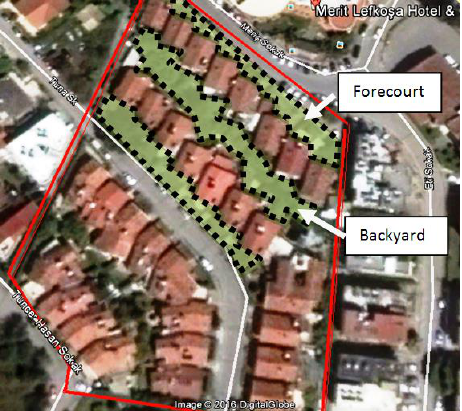
Figure 15. The Patio in the Efruz houses between two rows of building and forecourts in the frontage of each house.